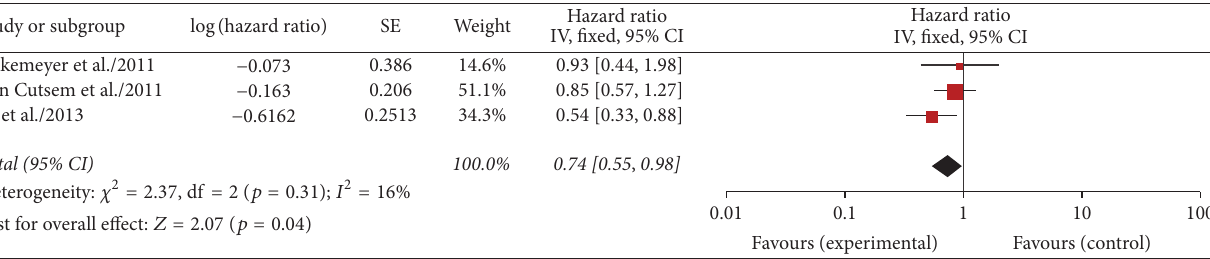
CIStudy or subgroup